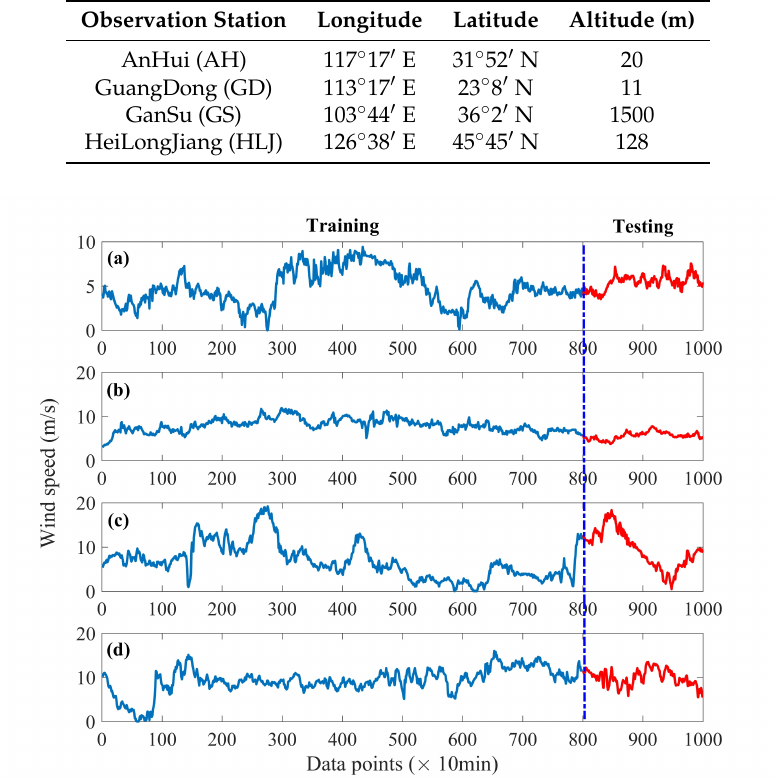
Figure 2. Wind speed series with 10 min interval at four sites in China: ( a ) AnHui (AH); ( b ) GuangDong (GD); ( c ) GanSu (GS) and ( d ) HeiLongJiang